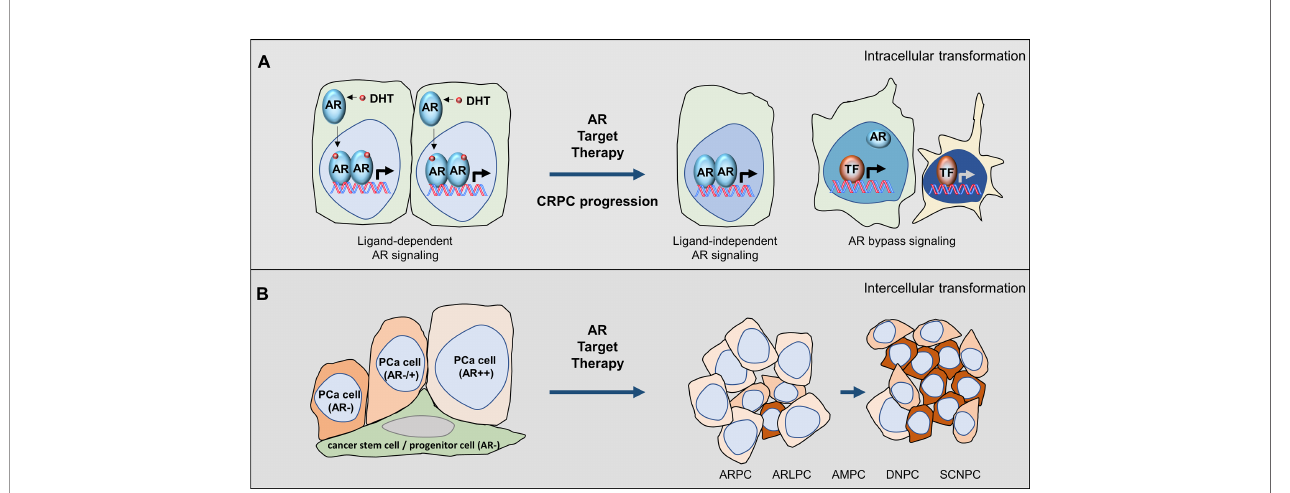
FIGURE 1 | Castrate-resistant prostate cancer progression is coupled with AR pathway inhibitions. (A) Intracellular mechanisms can be adopted by PCa cells under ARPI treatments that shift the ligand-dependent AR signalling to the ligand-independent AR signalling and AR bypass oncogenic pathways. (B) Intercellular mechanisms can be adopted by tumours under ARPI treatments to select tumours that are less dependent on androgens to survive and populate. During this process, tumours exhibit heterogeneous phenotypes that can be classi fi ed by luminal epithelial markers such as AR and PSA and neuroendocrine markers such as